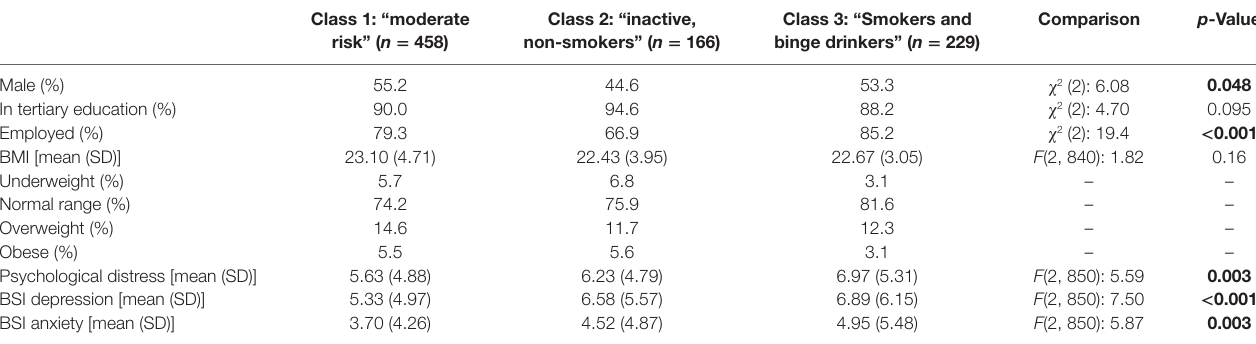
Bolded p-values indicate p < 0.05.